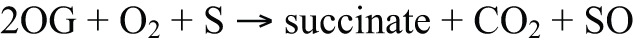
Catalytic mechanism for 2-oxoglutarate-dependent dioxygenases. Abbreviations: S, prime substrate; SO, oxidized prime substrate.